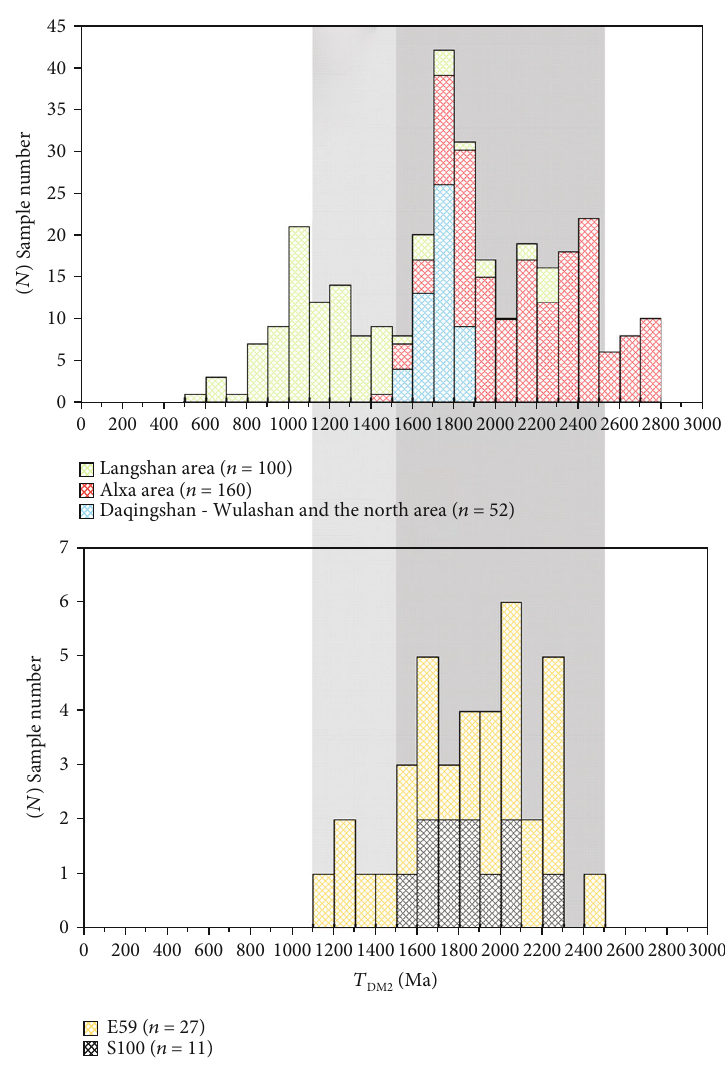
Figure 6: Two-stage model age comparison of Hf isotopes of zircons in Paleozoic age groups in the study area and probable provenance area (data quoted from Tian Jian et al., 2009; [32, 33]; Zhang Yun et al., 2019; Bao et al., 2019; [37]; Zhang Qiao et al.,